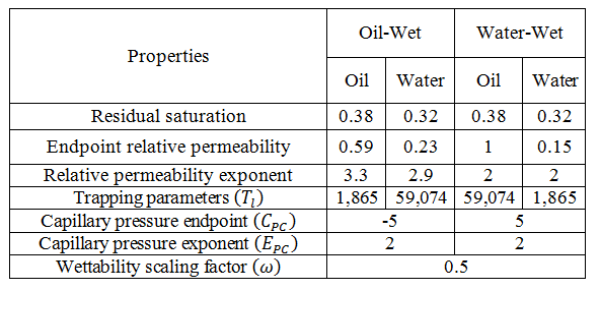
Table 3: The parameters of relative permeability and capillary pres- sure